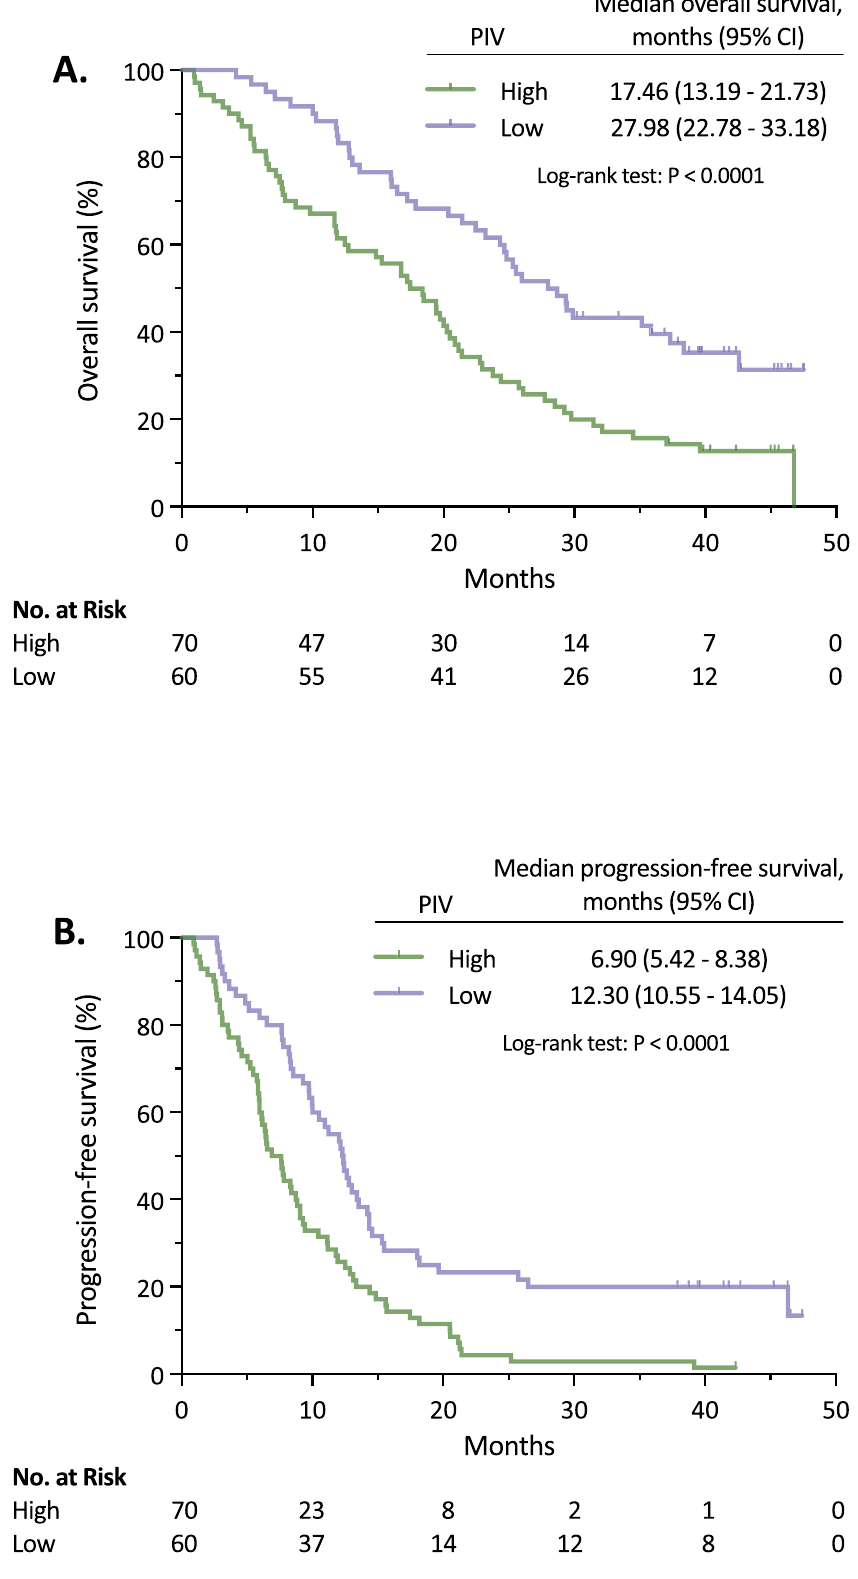
Figure 1. Kaplan–Meier survival estimates according to baseline PIV. ( A ) Overall survival. ( B ) Progression-free